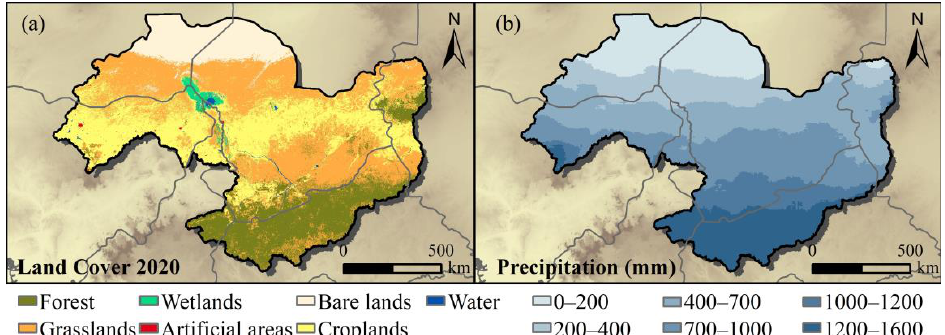
Figure 3. Spatial distribution of nature characteristics in the CLCB. ( a ) Spatial distribution of land cover; ( b ) Spatial distribution of precipitation. Table 4. Area and proportion of land cover types in the CLCB in 2020 (unit: km 2 ). Table 5. Annual average various data statistics of different land cover types in the CLCB between 2001 to Croplands